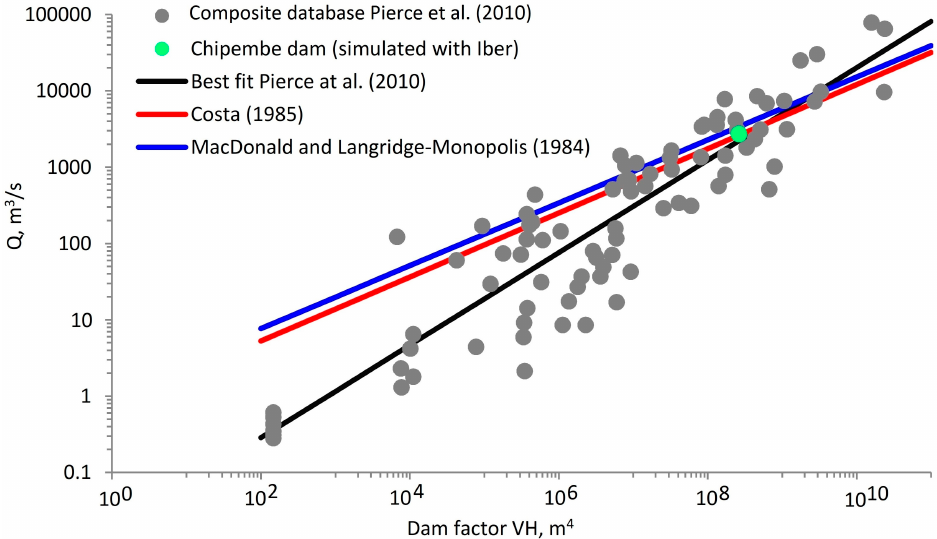
Figure 10. Comparison of the best-fit equations of MacDonald and Landgridge-Monopolis [58], Costa [59], Pierce et al. [27], and the peak flow predicted by the Iber model in Chipembe dam.